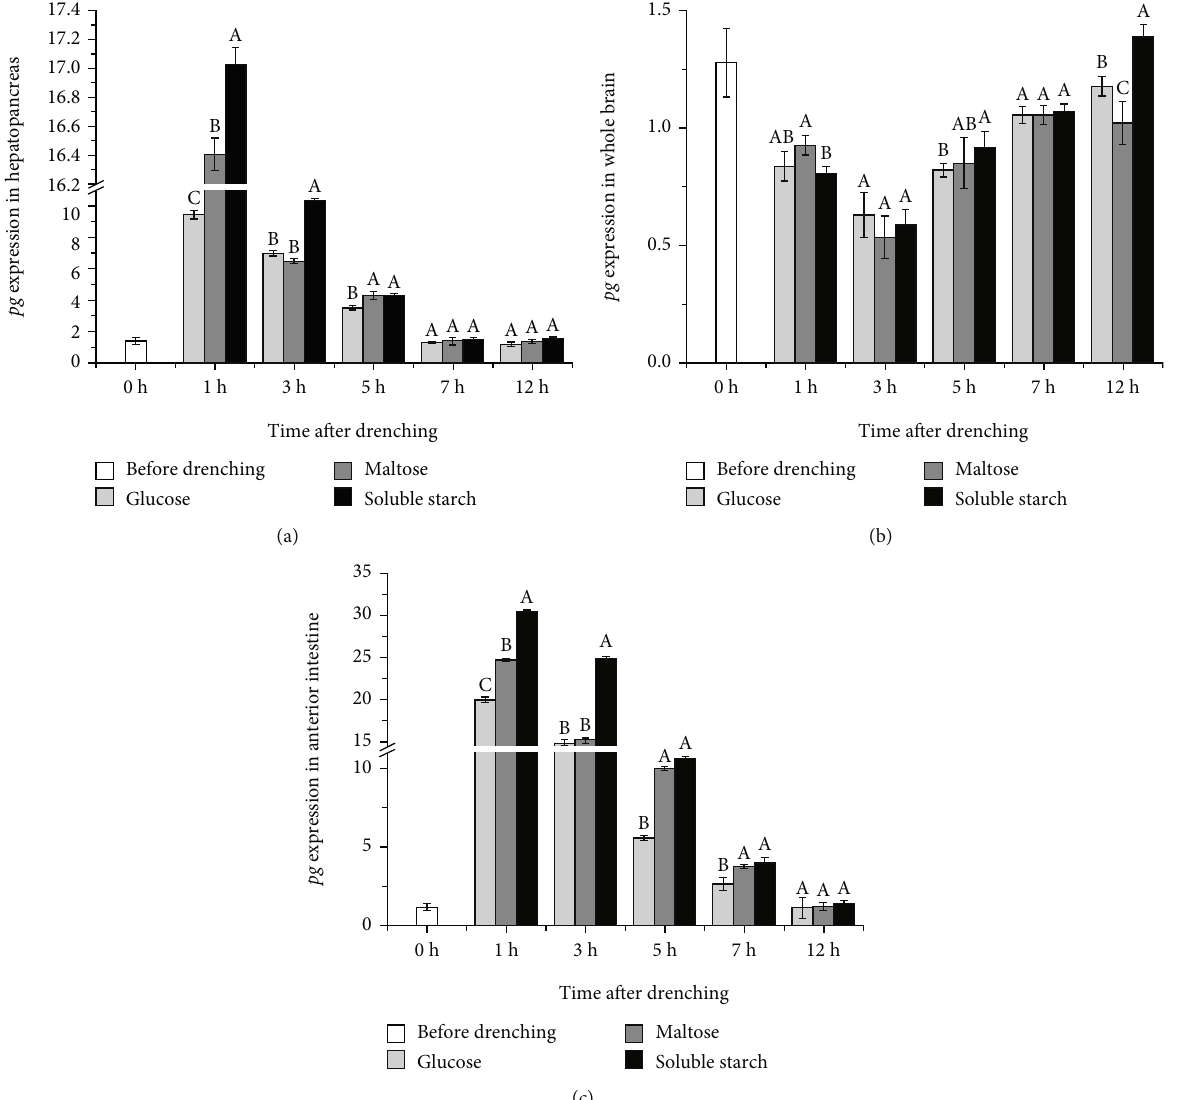
Figure 4: The e ff ects of oral administration of di ff erent carbohydrates on pg gene expression in the hepatopancreas, whole brain, and anterior intestine tissues. Di ff erent uppercase letters indicate the values with signi fi cant di ff erences ( P < 0 : 05